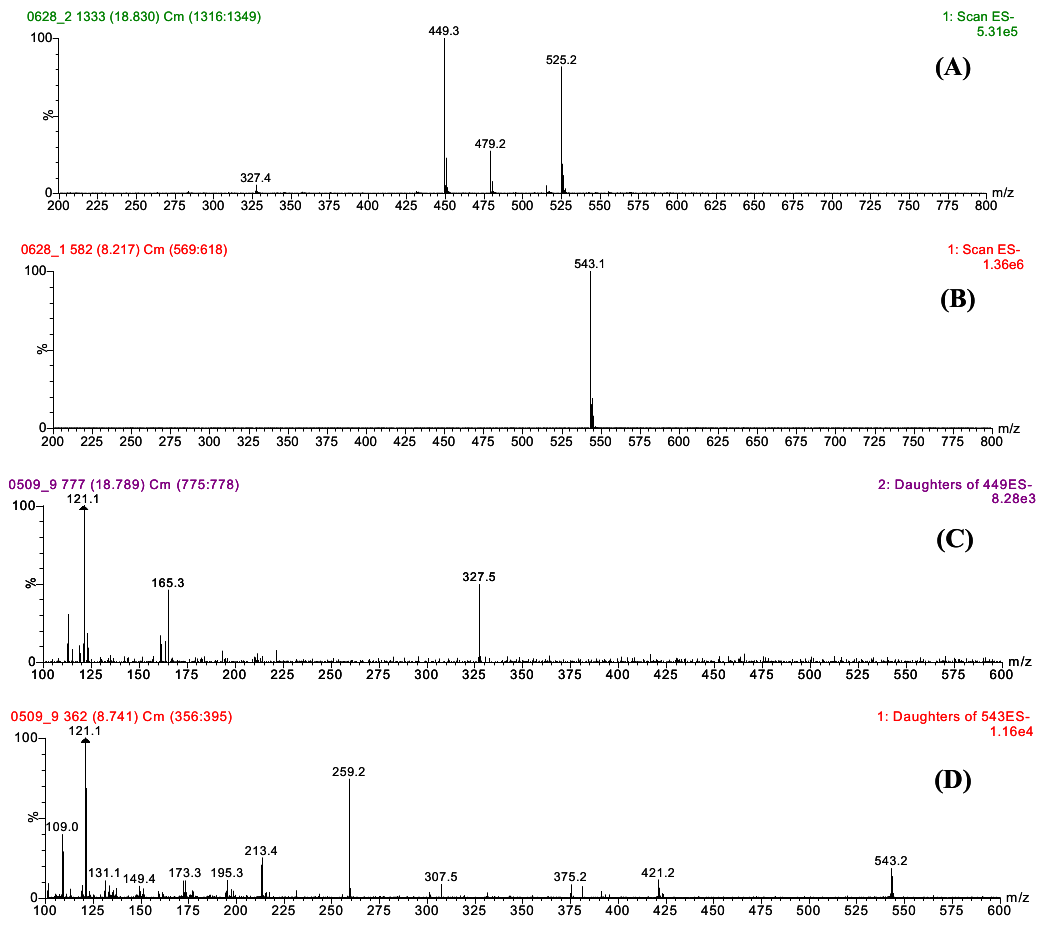
Figure 2. Mass spectra of paeoniflorin and paeoniflorin sulfonate. ( A ) full mass scan of paeoniflorin; ( B ) full scan of paeoniflorin sulfate; ( C ) daughter ion scan of paeoniflorin (parent ion m/z 449); ( D ) daughter ion scan of paeoniflorin sulfonate (parent ion m/z